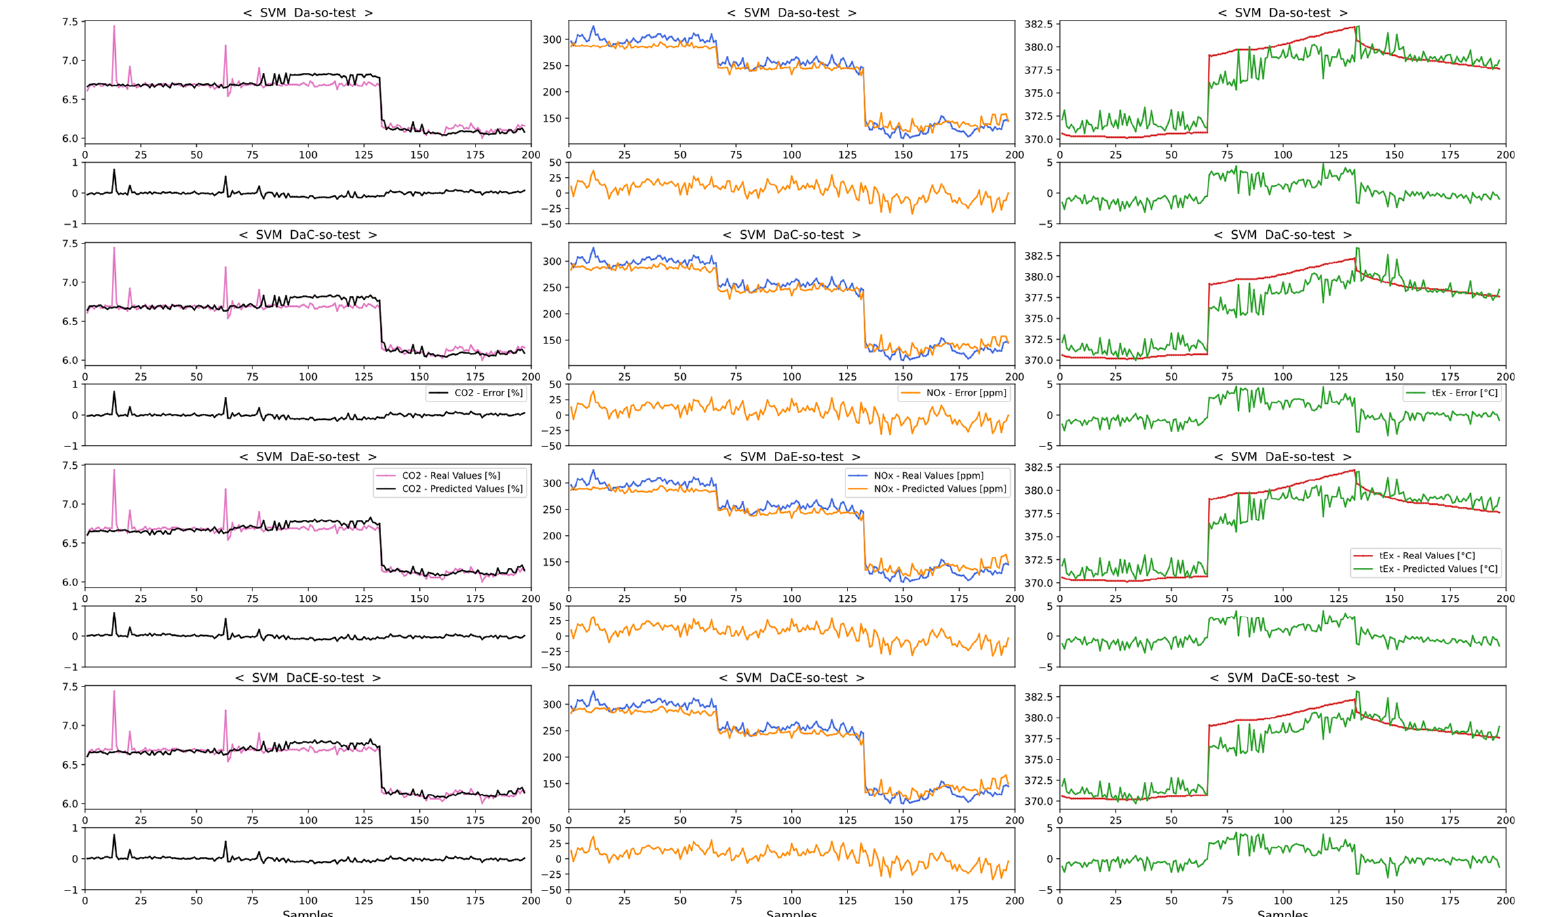
Figure 15. Comparison of real and predicted values for different datasets with SVM models in SCR mode.